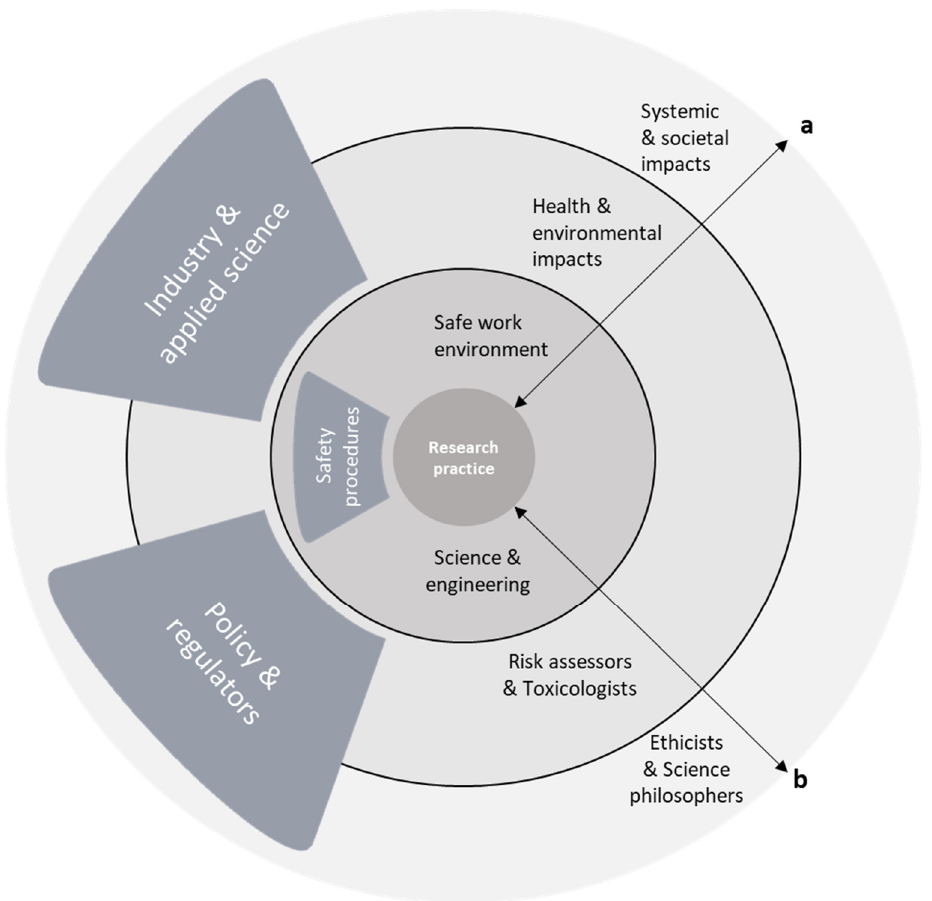
Figure 6. A complete visualization of boundaries, expertise and responsibility allocation around types of safety issues from the perspective of our respondents (arrow a depicts types of safety issues and distance from research practice, arrow b depicts pertinent expertise for increasing degrees of uncertainty).